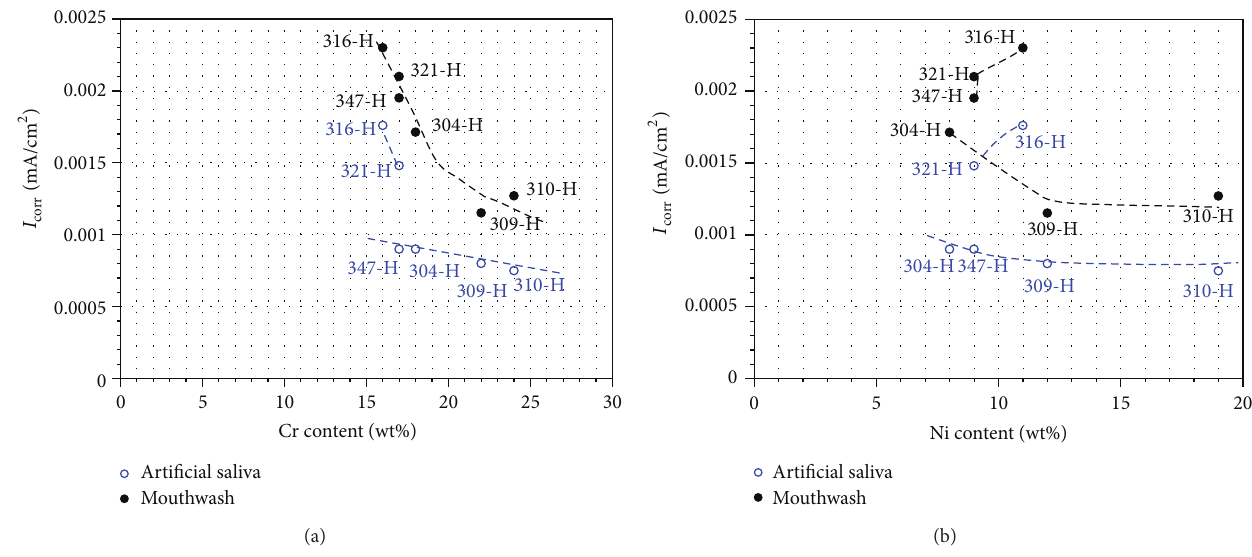
Figure 4: Effect of the Cr and Ni content of stainless steels on 𝐼